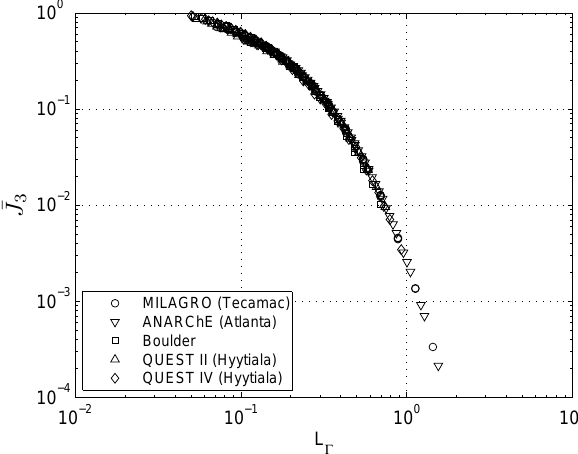
Fig. 3. Modeled peak ¯ J 3 as a function of L 0 ( L 0 = L 1 /0 1 ) for the analyzed measurement campaigns (locations), where L 1 is the dimensionless cluster scavenging parameter (Eq. 11) and 0 1 is the dimensionless cluster growth parameter (Eq.